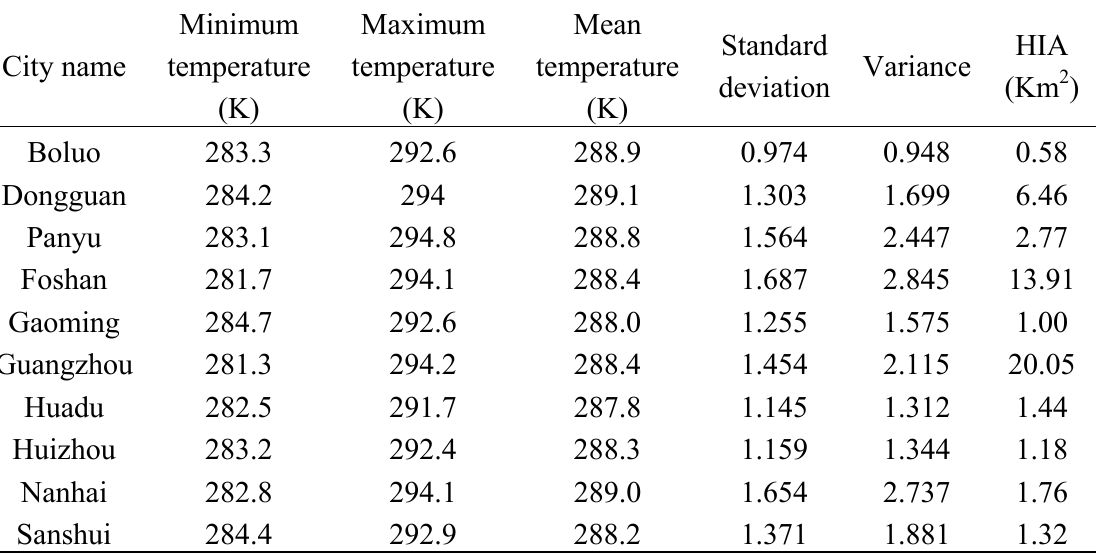
Table 2. The statistical results of surface temperature for the ten